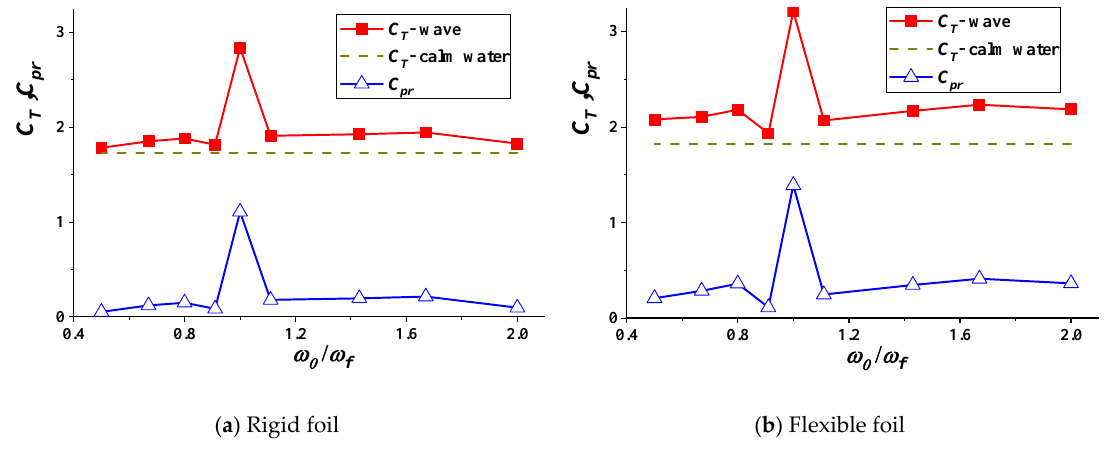
Figure 6. Average thrust and utilization wave power coefficients for the foil versus wave encounter frequency.